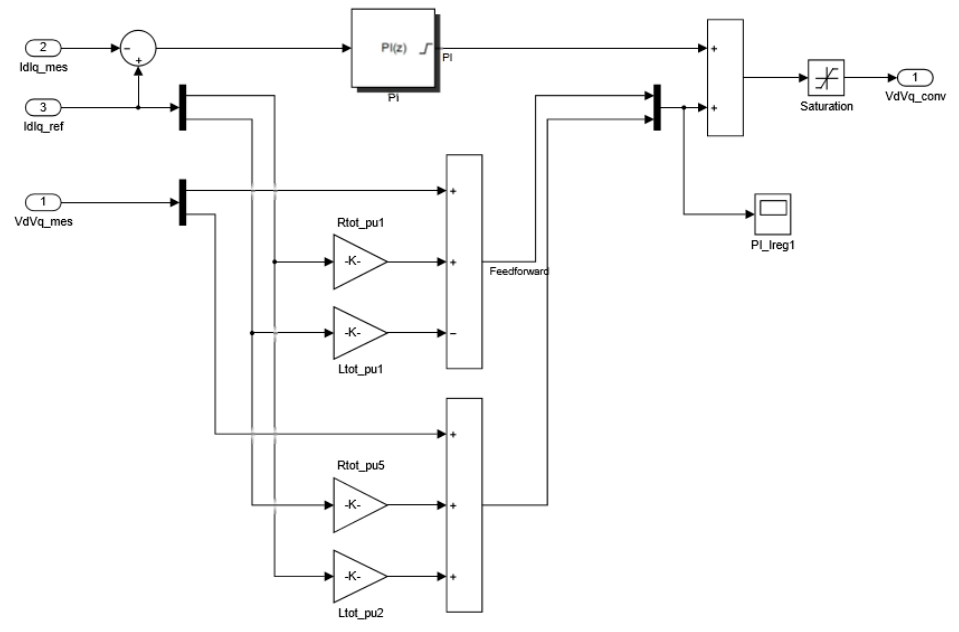
Figure 16. Current Control Loop.